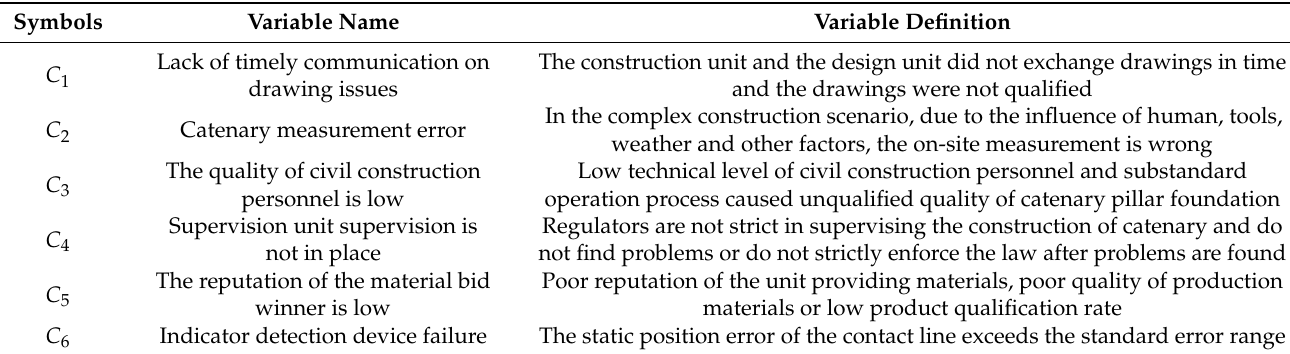
Table 1. Exogenous variables of catenary construction risks.